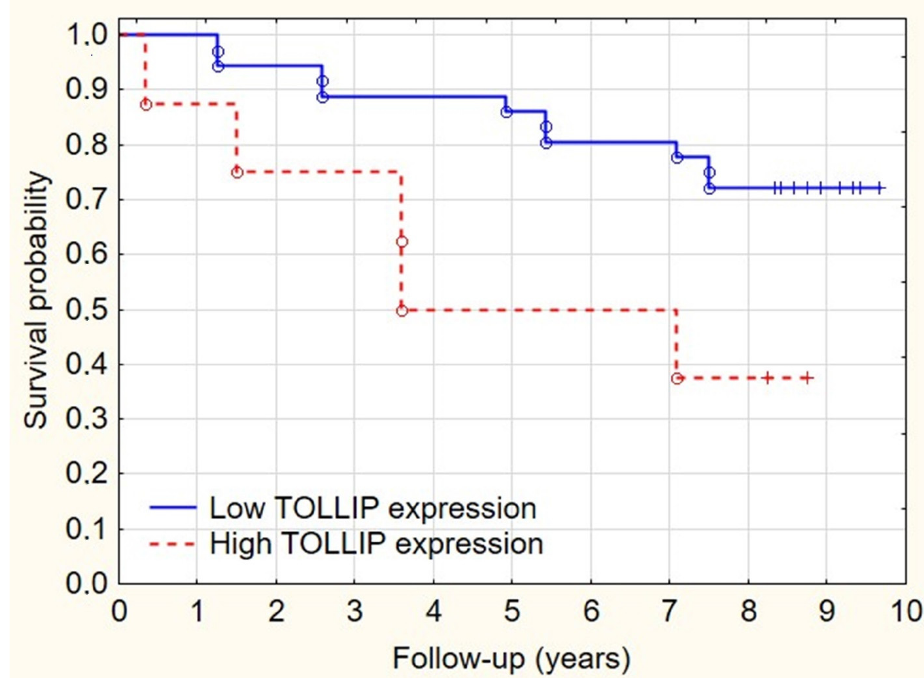
Figure 4. Survival differences in high and low TOLLIP expression groups.